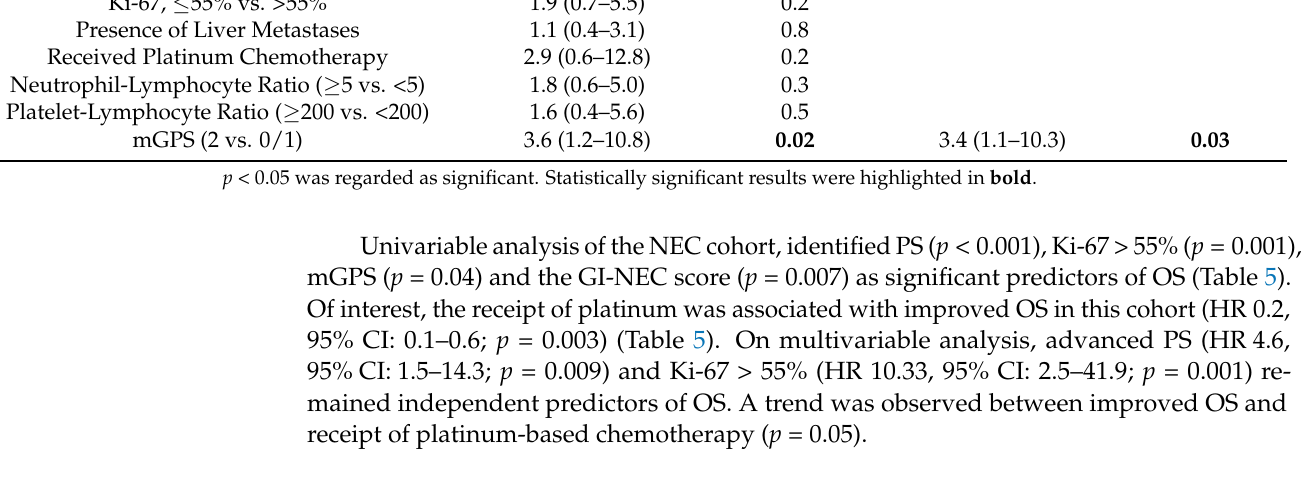
Table 5. Univariable and multivariable analysis for overall survival in